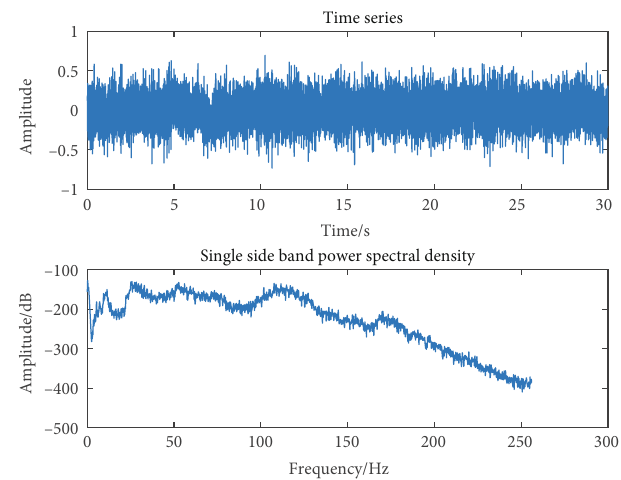
Figure 16: Time series and PSD of the horizontal tail in